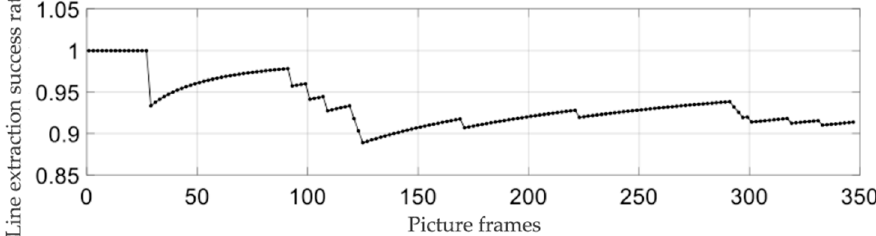
Figure 7. The relationship between line extraction success rate and frames.